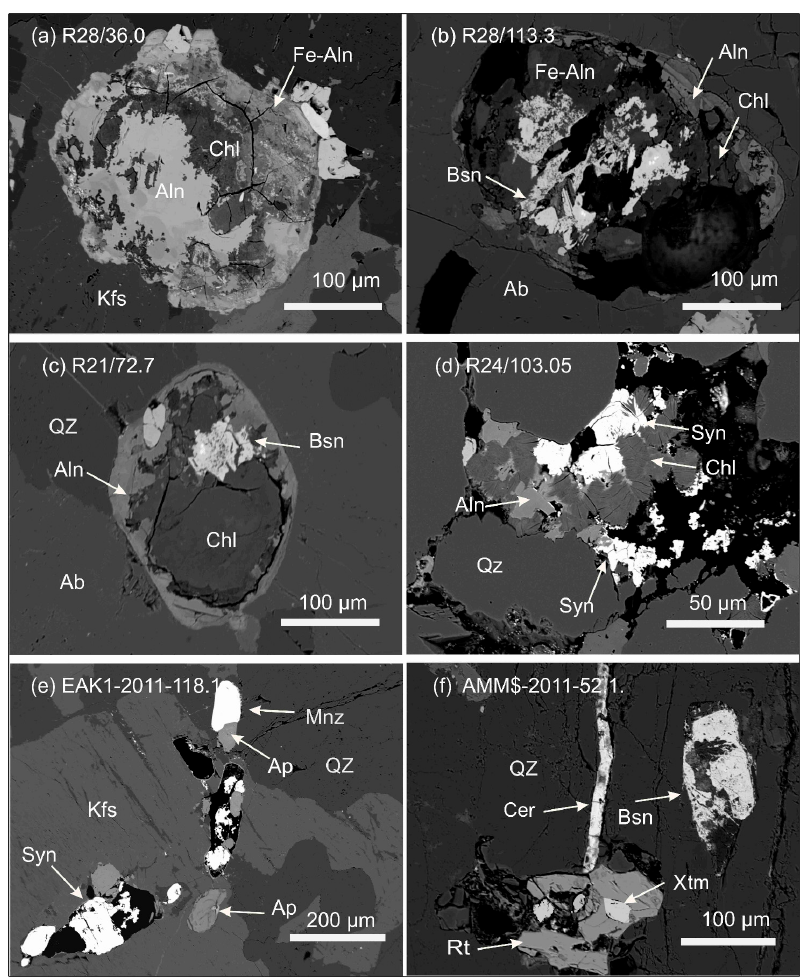
Figure 11. Back-scattered electron images REE-bearing minerals from arkose gneiss of Tana Belt; ( a – d ) Primary magmatic allanite (Aln) to ferriallanite (Fe-Aln) crystals in association with quartz (Qz), K-feldspar (Kfs), fluorapatite (Ap) and chlorite (Chl) and partly replaced by an assemblage of secondary REE carbonates bastnäsite (Bsn) and synchysite (Syn); ( e ) Synchysite filling within feldspar and in association with monazite and apatite; ( f ) Cerite (Cer) fills a small fractures in quartz and albite, and it is in contact with bastnäsite, xenotime (Xtm) and rutile (Rt). Transformation of allanite to secondary REE carbonate minerals (mainly bastnäsite and synchysite) has been described in numerous cases in various magmatic and metamorphic rocks e.g., [45–49]. However, such alteration of allanite is usually associated with clay minerals (kaolinite, montmorillonite), and also with thorite, fluorite, and magnetite without carbonate minerals in some cases [45,50]. In contrast, allanite in the samples from the Tana Belt was replaced mainly by bastnäsite